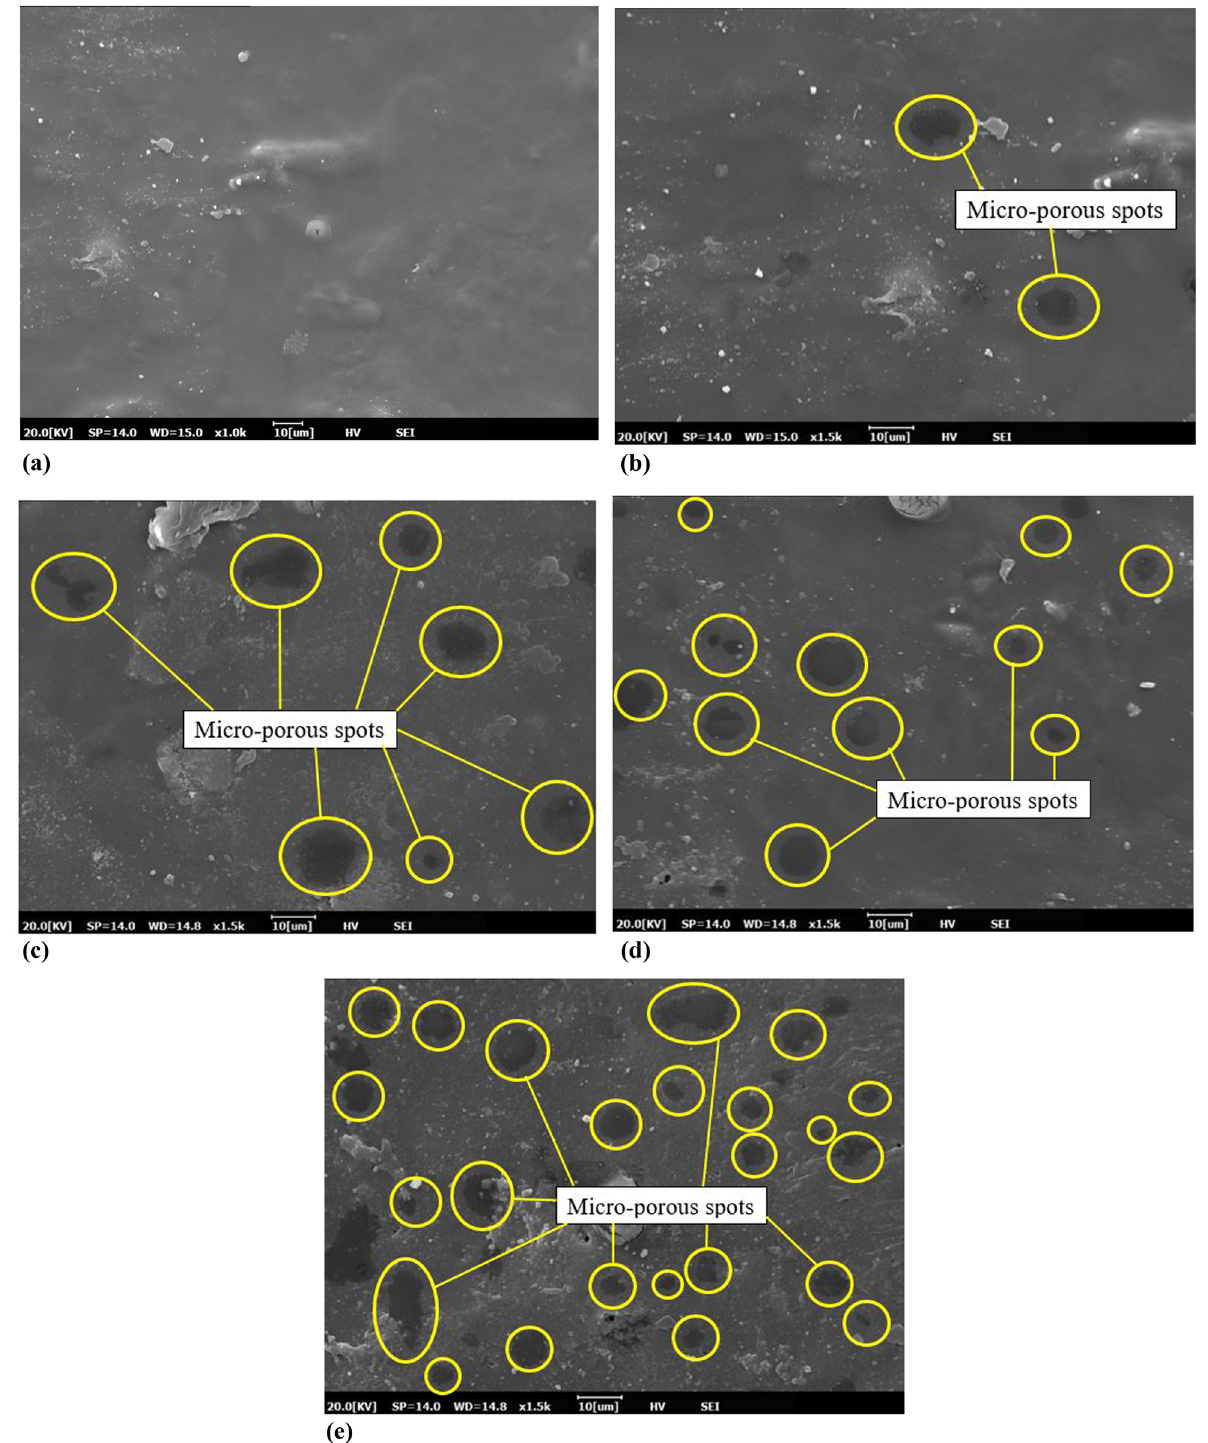
Figure 2: SPN/SPS biocomposite fi lm incorporated with ( a ) 0%, ( b ) 0.8%, ( c ) 1.2%, ( d ) 1.6 and ( e ) 2.0% of